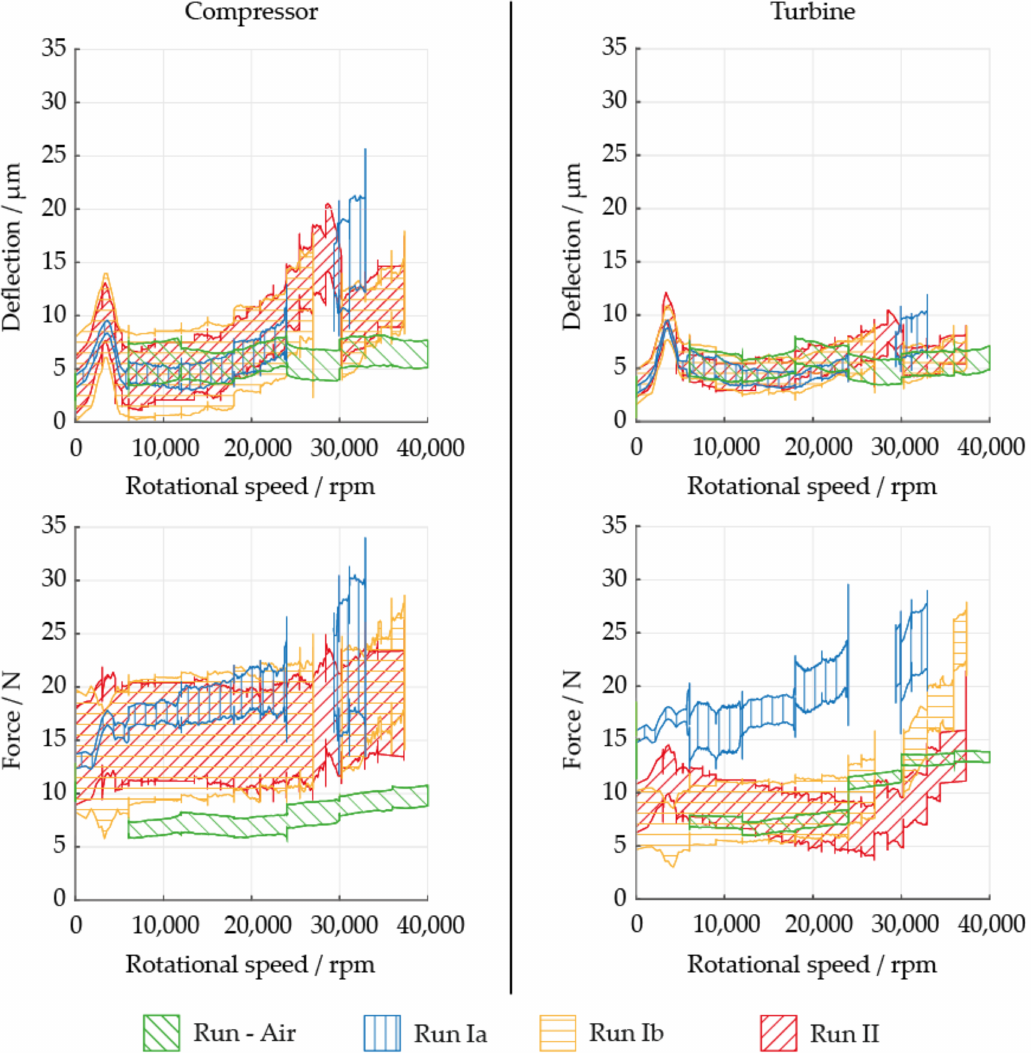
Figure 9. Deflections and forces depicted as function of speed for region III in Figure 6 compared to previous test runs: ( top ) deflections; ( bottom ) forces; ( left ) at compressor bearing; ( right ) at turbine